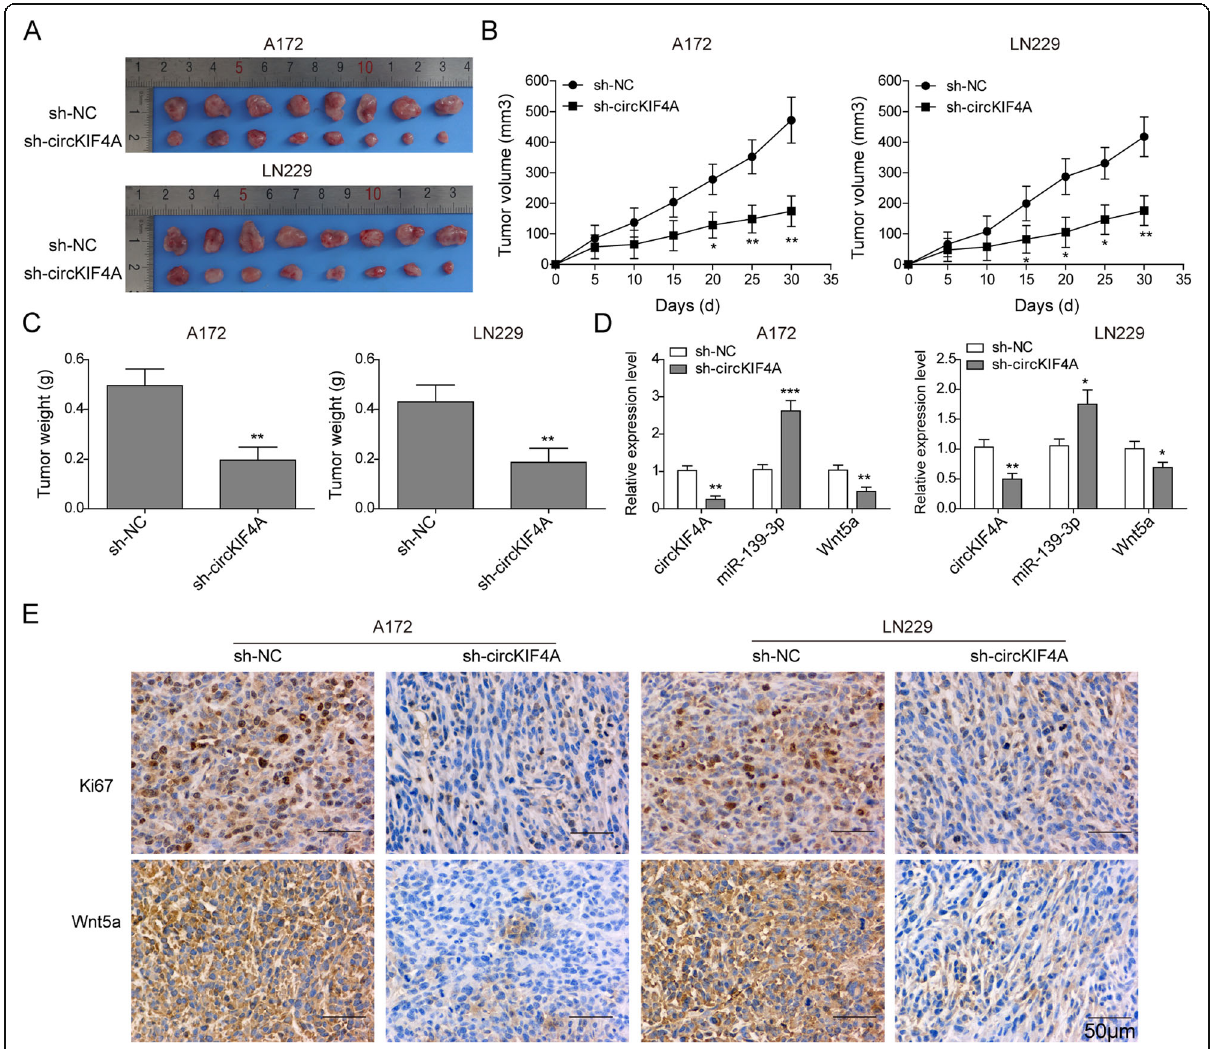
Fig. 7 circKIF4A knockdown suppressed glioma cells tumorigenesis in nude mice. A172 and LN229 cells stably expressing sh-circKIF4A were injected into the nude mice. a Representative pictures of isolated xenografts were shown. b The tumor volume of each mouse was measured every 5 days. c 30 day later, the tumor weight of each group mouse was measured. d The expression level of circKIF4A, miR-139-3p and Wnt5a was measured by qRT-PCR. e Ki67 and Wnt5a protein level was detected by immunohistochemical staining. * p < 0.05, ** p < 0.01, *** p <